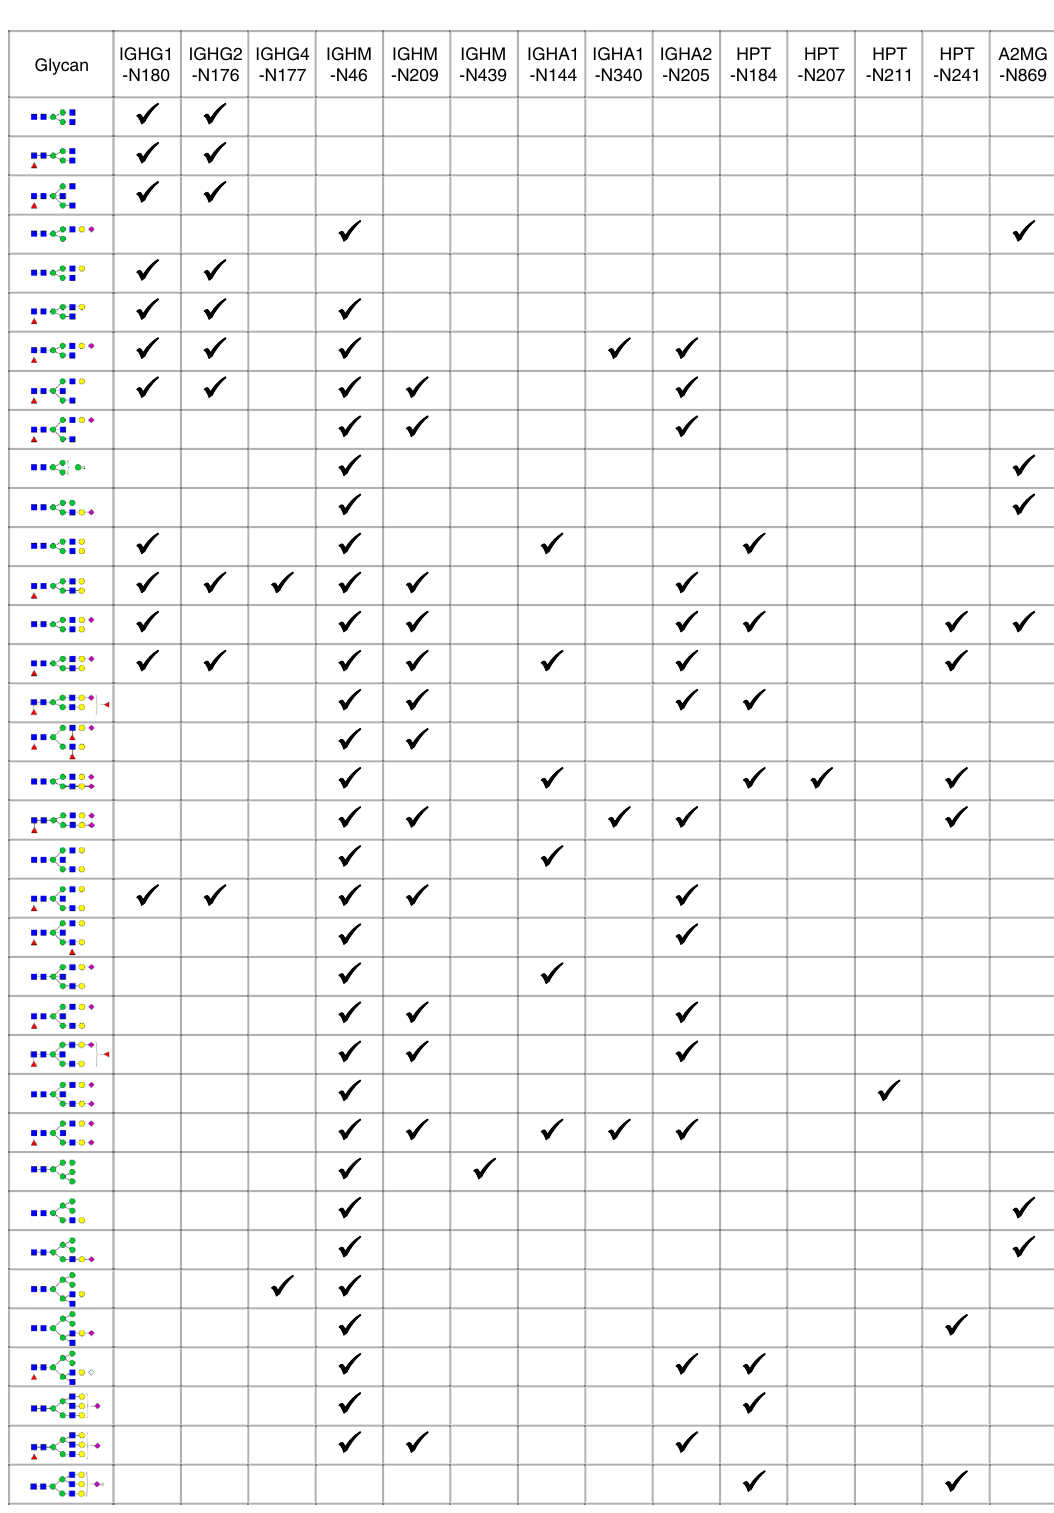
Fig. 3 Analysis of a standard glycoprotein mixture. Protein names and glycosylation sites are listed in the fi rst row, and glycans are listed in the fi rst column. Identi fi ed site-speci fi c glycans are ticked in the table. Glycans identi fi ed at more than one glycosylation site are shown